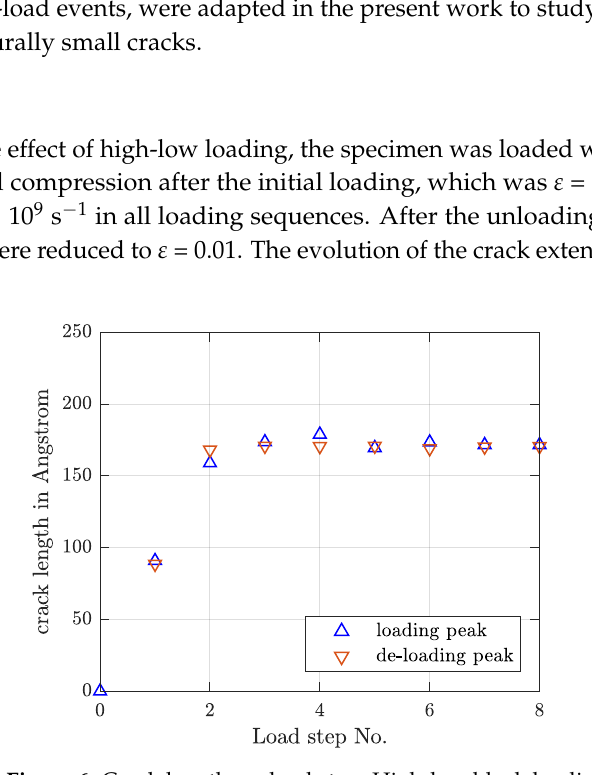
Figure 6. Crack length vs. load step. High-low block